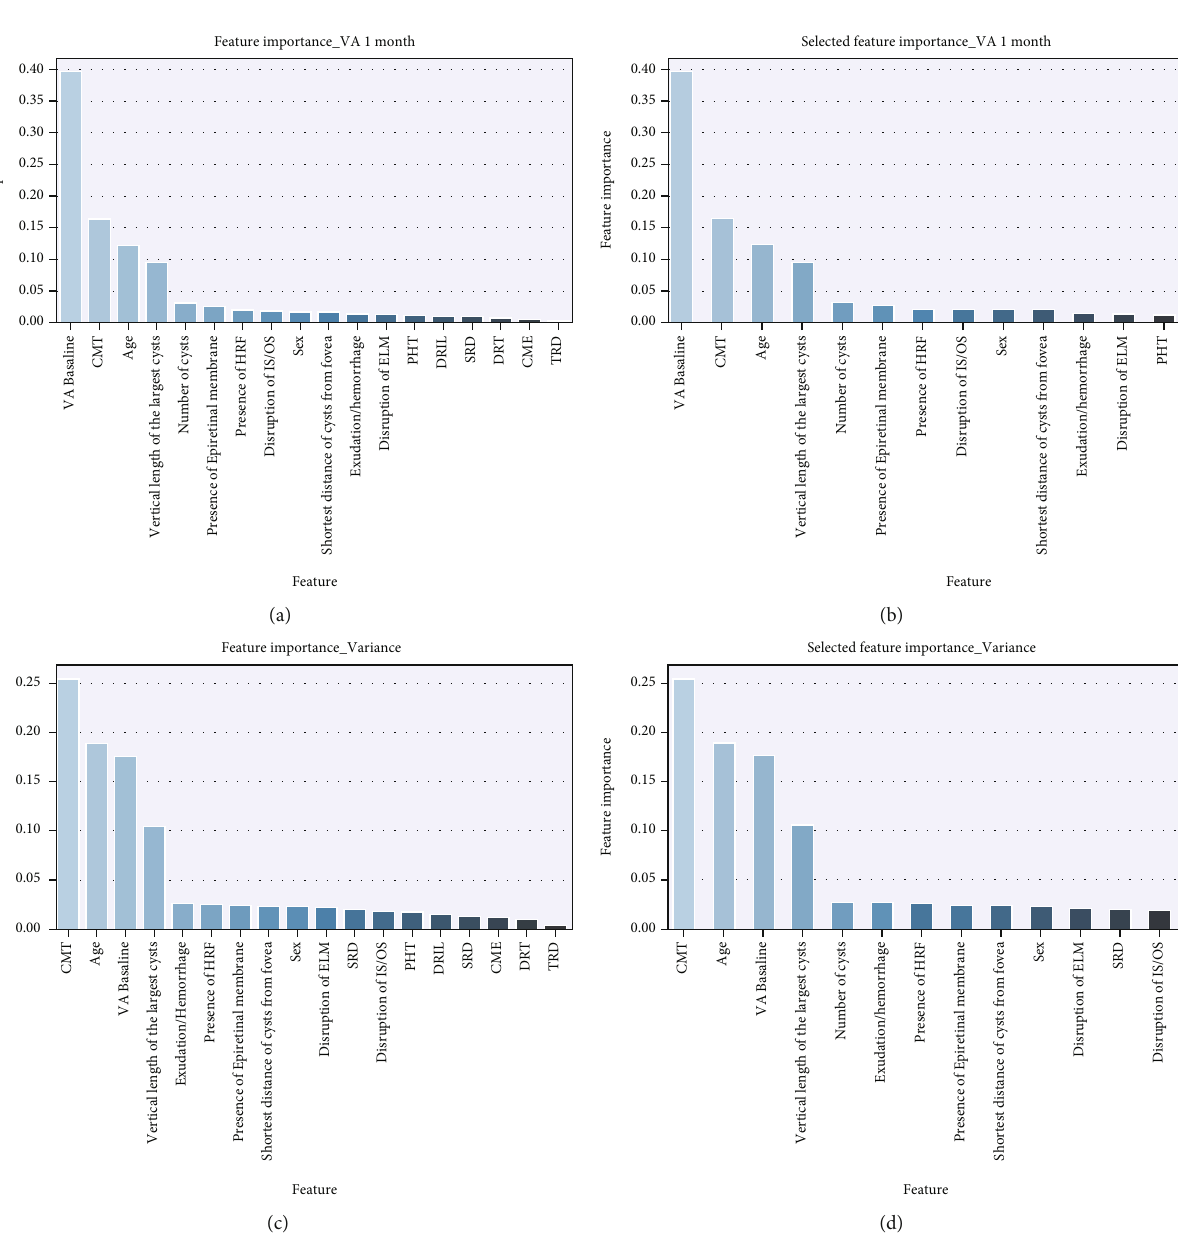
Figure 3: Relative importance of di ff erent features for VA and VA variance predictions. The plot showed the weight of di ff erent features for the VA (a, b) and VA variance (c, d) prediction task. The blue bar indicated how important the feature was for the model on the di ff erent test